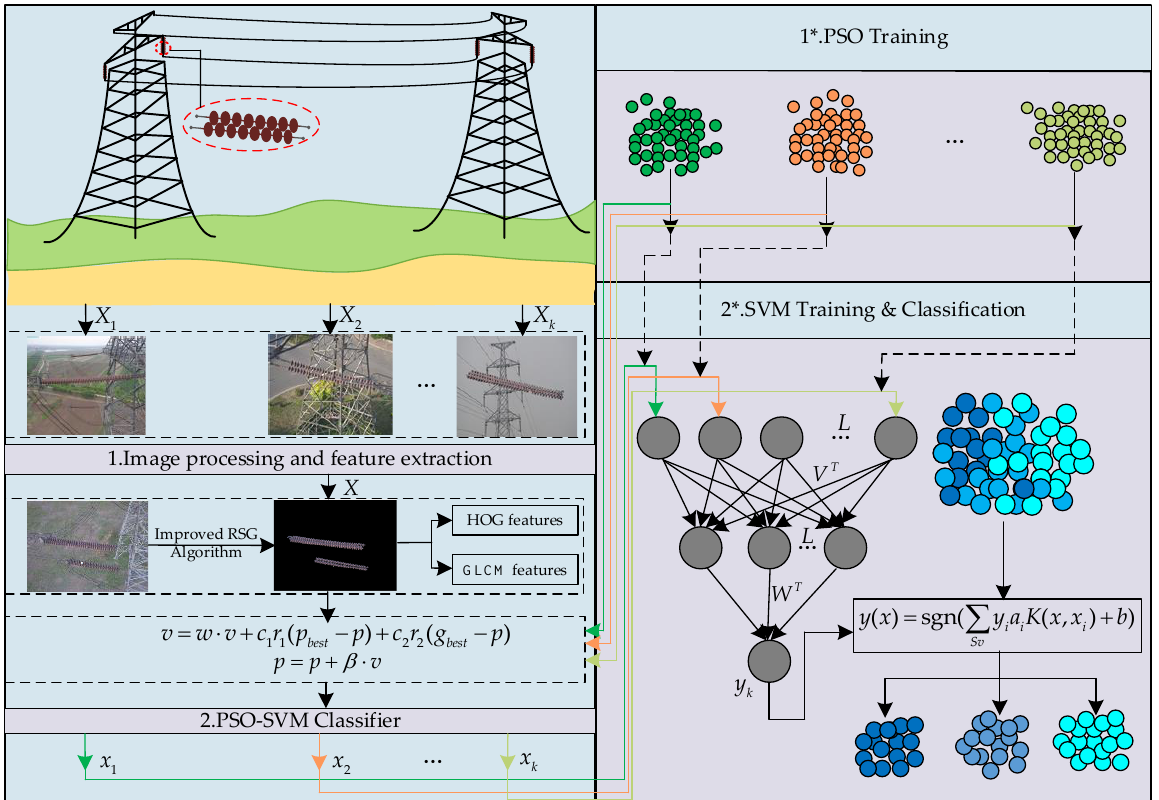
Figure 2. Schematic diagram of the proposed method for insulator state detection.